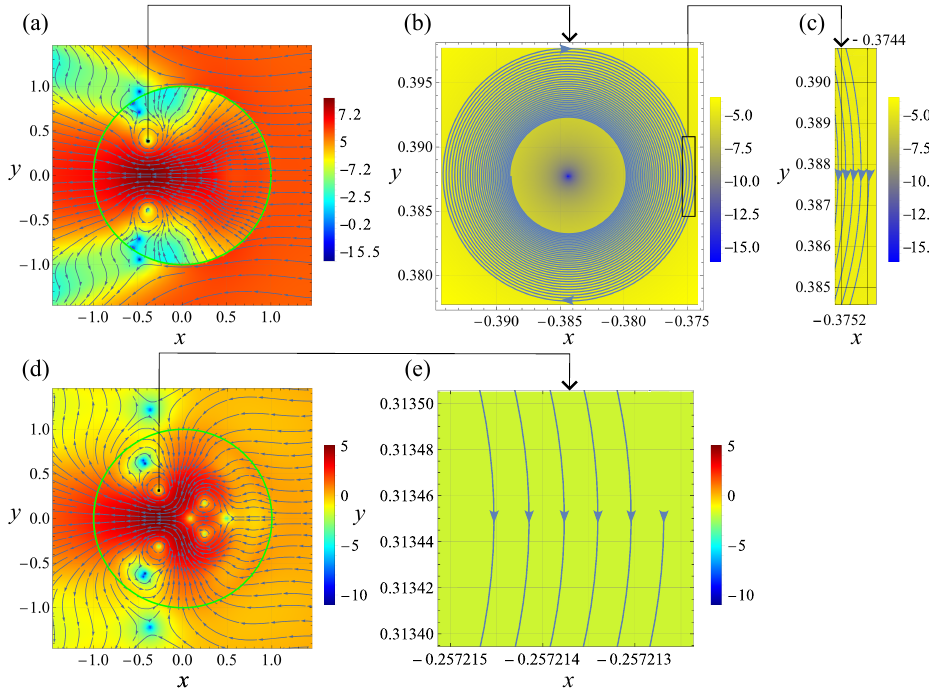
Figure 2. Light scattering by a Germanium cylinder in a vacuum. λ = λ 1 = 1590 nm. ε ( λ 1 ) ≈ 17.775 + i 0.024. Streamlines for the Poynting vector field. The pattern is symmetric with respect to the line y = 0. The green circles in ( a , d ) designate the surface of the cylinder. The color indicates the value of ln | S | 2 ; see the color bars. The panels in the upper and low rows correspond to the TE and TM polarization of the incident wave, respectively. Panel ( b ) is a zoom of the vicinity of the singular point shown in ( a ) as a small black rectangle. The same is true for ( d , e ). Panel ( c ) is a zoom of the region marked in ( b ) as a rectangle. See text for